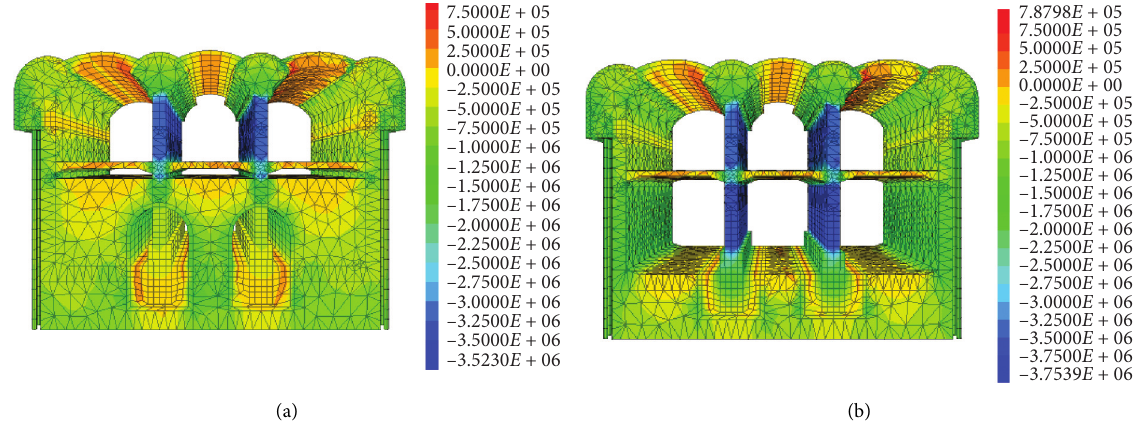
Figure 17: Principal stress of middle columns (pa).